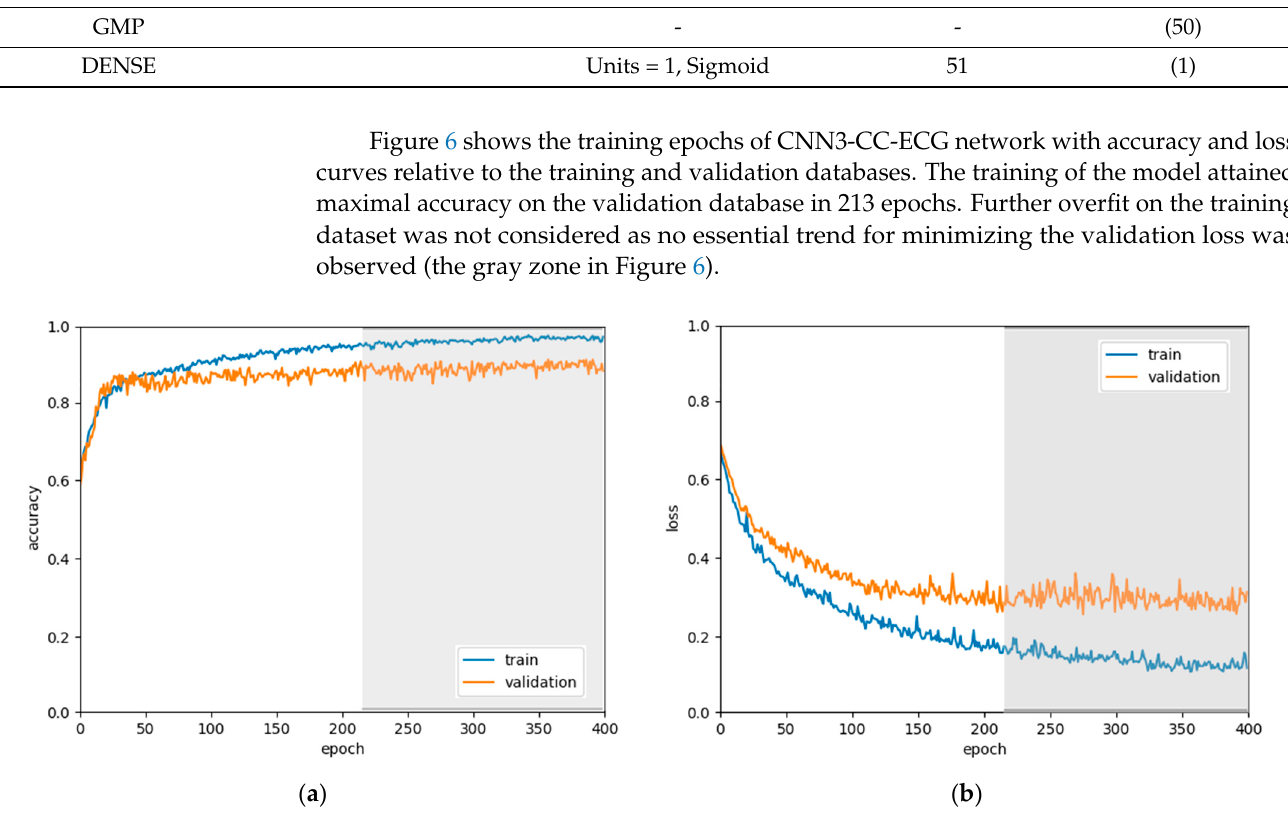
Figure 7. ROC curves of CNN3-CC-ECG network for the validation and test databases. The thresh- old of the ROC operating point for the validation database (black ‘o’ mark) was computed at